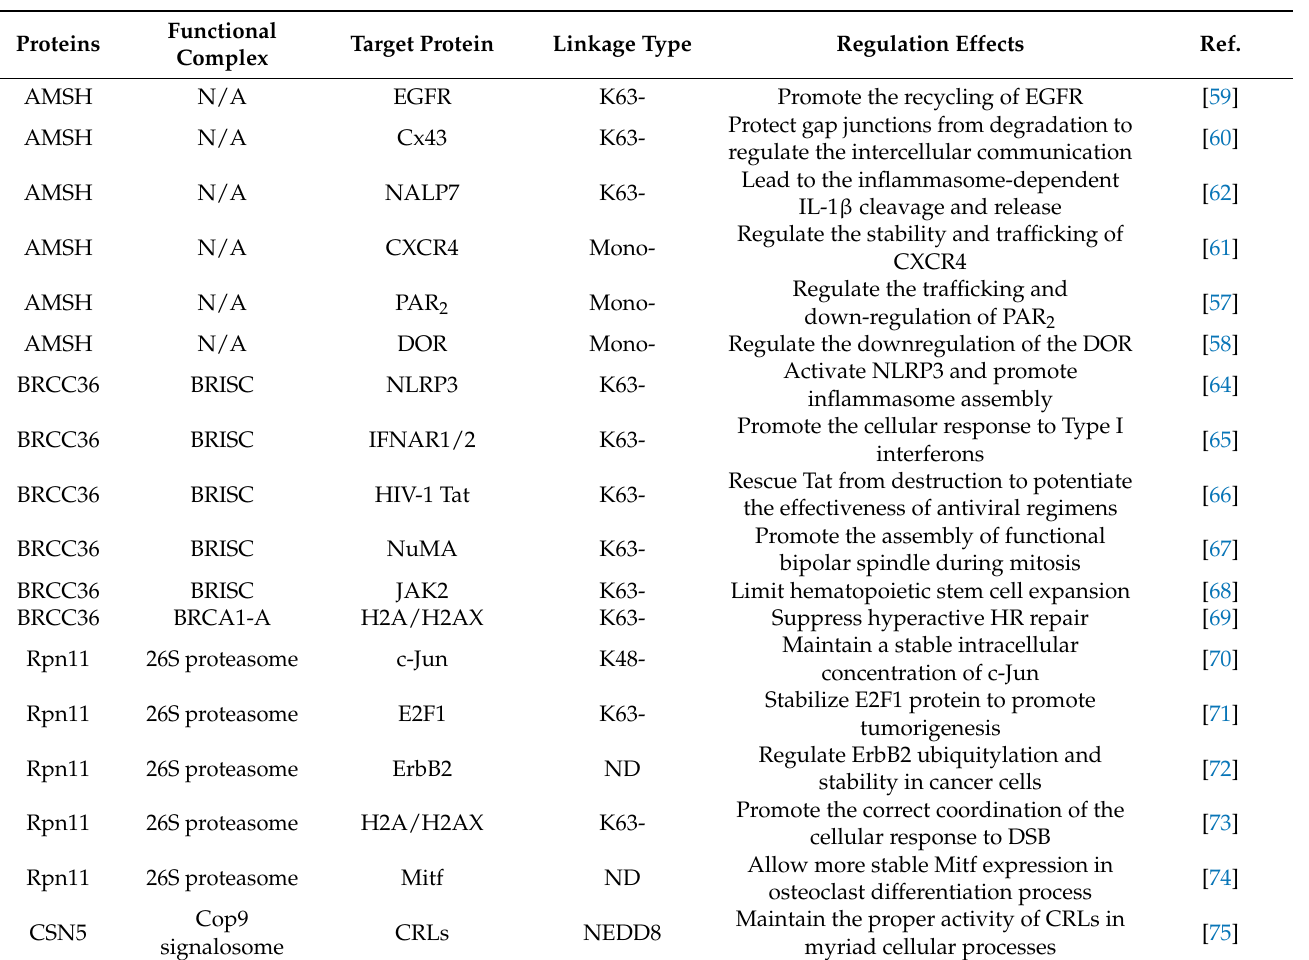
Table 1. List of JAMMs mentioned in this review and their functional